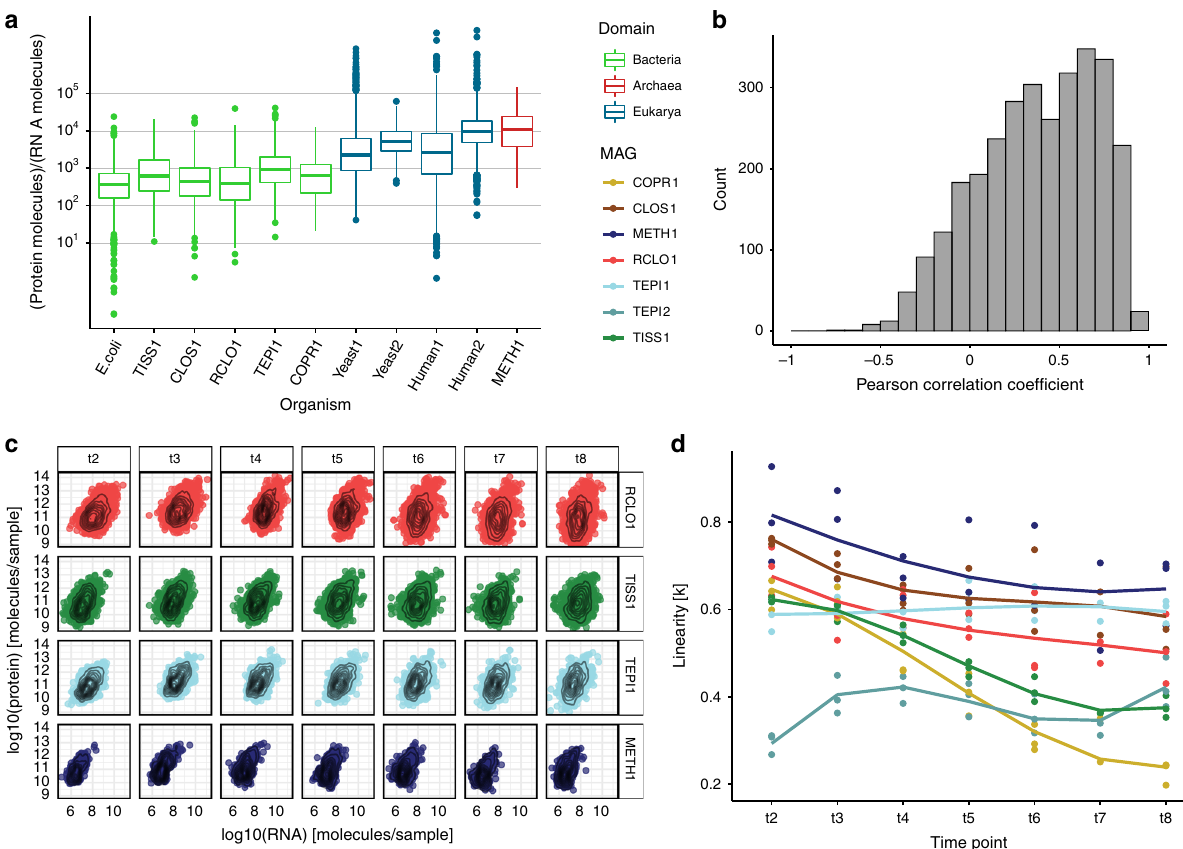
Fig. 2 Protein-to-RNA ratio distributions within a microbial community. a Comparison of the boxplot of protein-to-RNA ratios of selected MAGs reconstructed from the SEM1b community as well as those previously reported in the literature. (Bacteria: green, Archaea: red, Eukarya: blue). The boxes span the 25th – 75th percentiles with the central bars being the medians. Whiskers extend maximum up to 1.5× the inter-quartile range or, if possible, until the most extreme of the data points. Points beyond the whiskers are considered outliers. The protein-to-RNA ratios for E. coli was retrieved from Taniguchi et al. 2 , Yeast1 from Ghaemmaghami et al. 21 , Yeast2 from Lu et al. 22 , Human1 from Schwanhausser et al. 23 and Human2 from Li et al. 24 . The number of independent genes per organism used in the plot are as follows: E. coli = 1018, TISS1 = 587, CLOS1 = 783, RCLO1 = 799, TEPI1 = 433, COPR1 = 75, Yeast1 = 6238, Yeast2 = 6330, Human1 = 5028, Human2 = 5028, METH1 = 93. b The distribution of the Pearson correlation coef fi cients (PCC) between transcripts and their corresponding proteins computed across the time points. With a median PCC of 0.41, the change in the amount of a given transcript over time seemingly does not translate into a change in the amount of the corresponding protein. c . Per time-point scatterplots of the absolute protein and transcript levels for ORFs that produced both detectable transcript and protein in SEM1b data sets. For simplicity, only four representative MAGs are shown, with all MAGs depicted in Supplementary Fig. 2. d The plot shows how the linearity parameter k between RNA and protein changes over time for the different MAGs. The linearity represents how a change in RNA level is re fl ected in a change in the corresponding protein level. The third-grade polynomial fi t allows up to two bends to the curve. The parameter ranges from 0 to 1, and increasingly smaller values translate in fewer proteins being expected for the same level of RNAs. The populations CLOS1, METH1, and TEPI1 are converging toward the same values, while RCLO1 has a parallel trend, which collectively suggests the existence, and the reaching of a metabolic equilibrium among